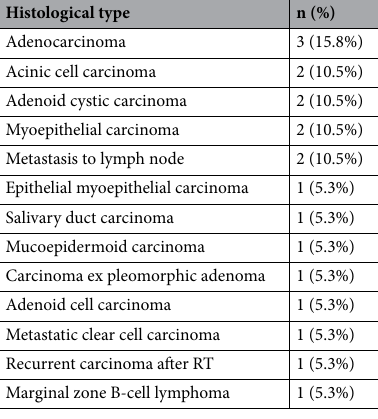
Table 2. Distribution of malignant parotid tumors identified in the analyzed material according to their microscopic